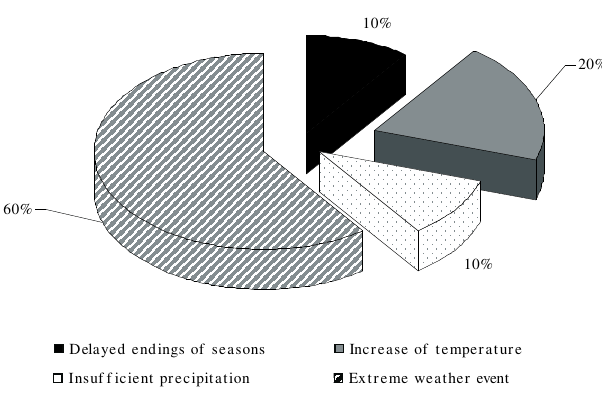
Figure 1. ’In your opinion, what does climate change mean?’ p=0.000, p ≤ 0.05 Source: On the basis of empirical research